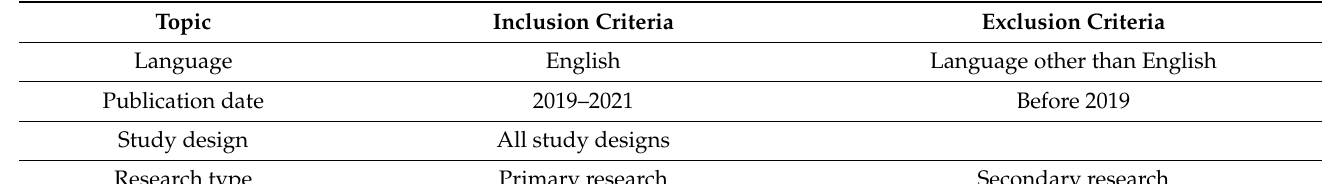
Table 1. Inclusion and exclusion criteria for the scoping